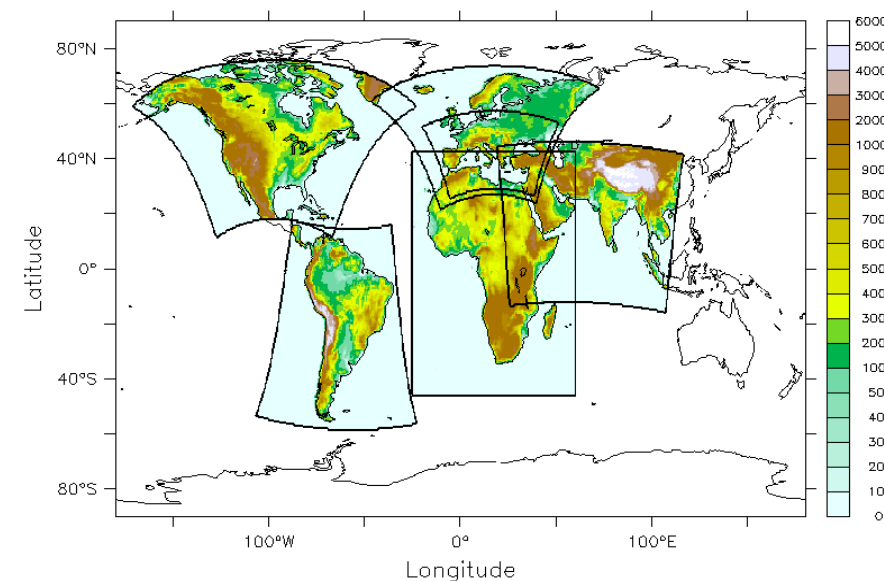
Figure 1. Orography (m) of the 6 COordinated Regional Climate Downscaling EXperiment (CORDEX) model